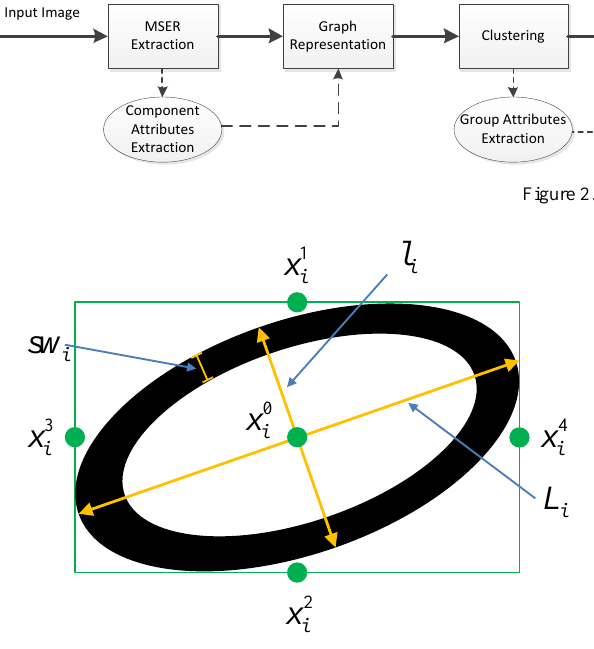
Figure 3. Attributes of MSER components.